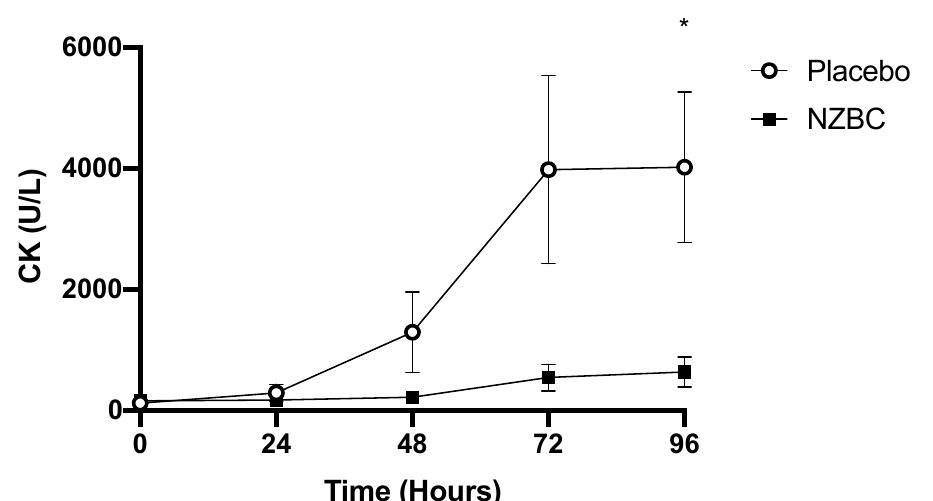
Figure 2. Creatine Kinase (CK) before and after eccentric exercise in the PLA and NZBC groups. Values are means ± SEM, * significant difference between groups ( p < 0.05).